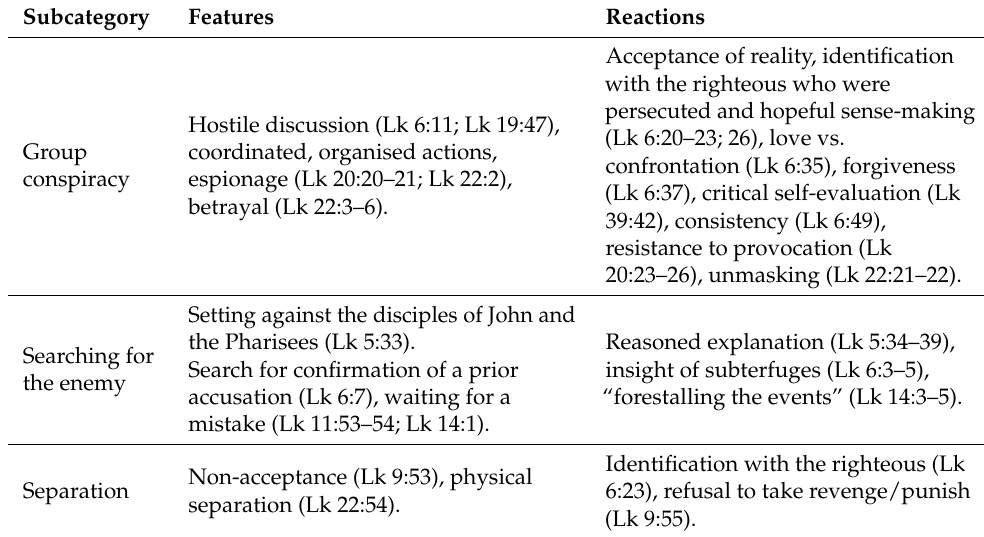
Table 4. Features of building a hostile group–person relationship.